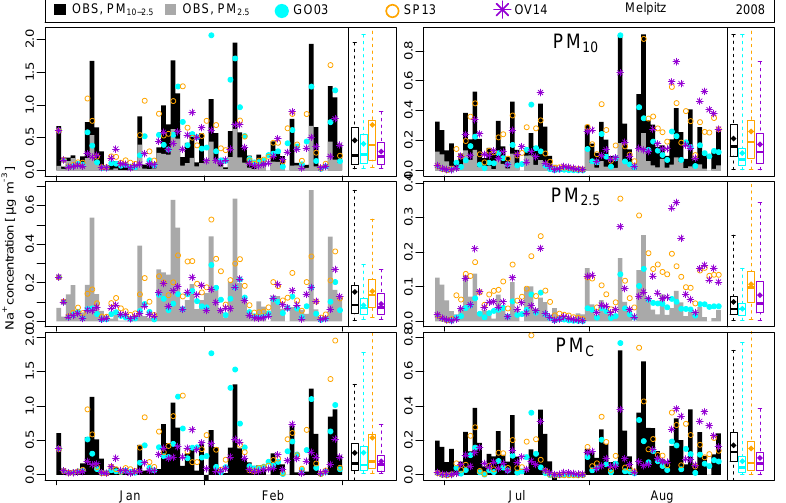
Figure 11. Daily average measured and modeled sodium concentrations at the EMEP station at Melpitz. The sodium PM 10 , PM 2 . 5 and PM C concentrations are plotted in the top, center and bottom rows, respectively, for winter (left) and summer (right). The black box plot represents the observations. For the box plots of the modeled data, only the daily model values with corresponding measured values are considered. tions with respect to their magnitude. SP13 and OV14